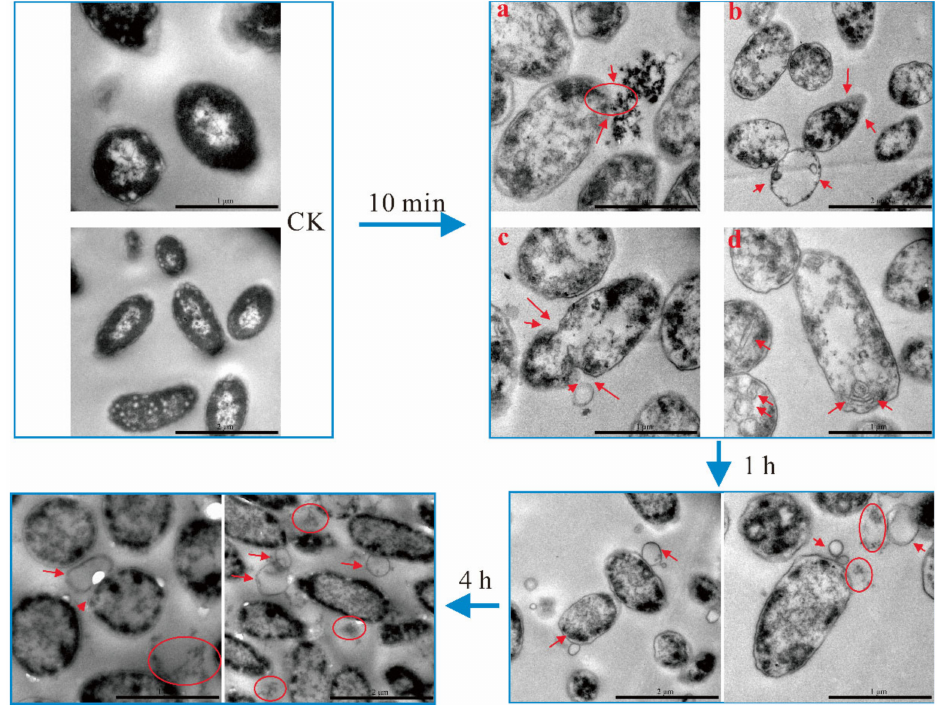
Figure 5. Changes of morphology and cellular materials of A. hydrophila after 10 min, 1 h, and 4 h treatment of LN observed by TEM. The red arrows indicated the damage of cell membrane, the red circles indicated intracellular material of